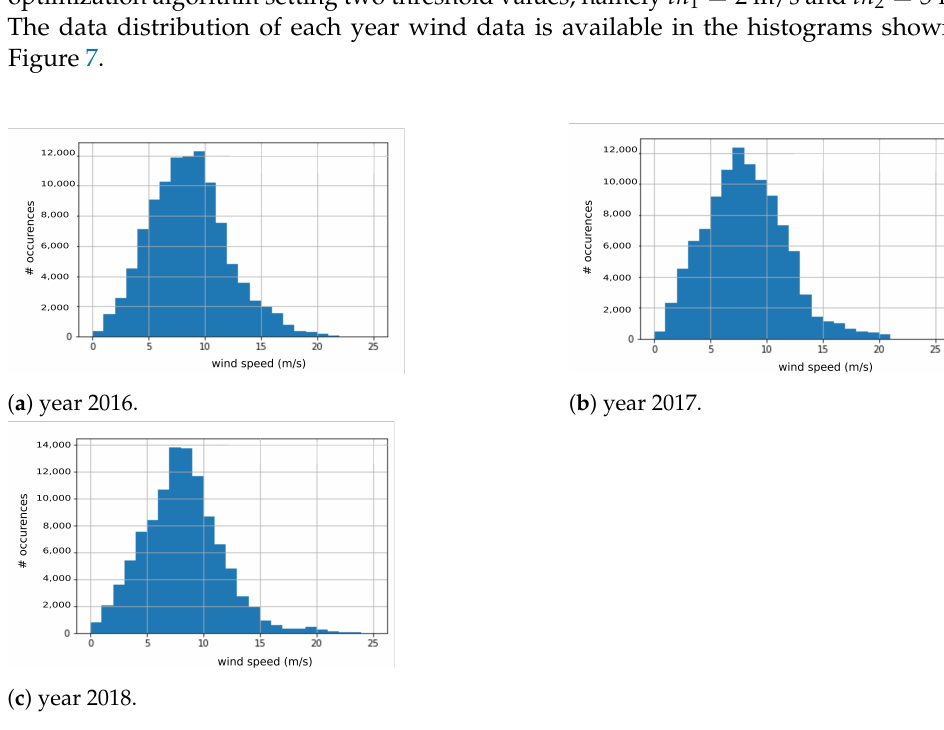
Figure 7. Distributions of the wind